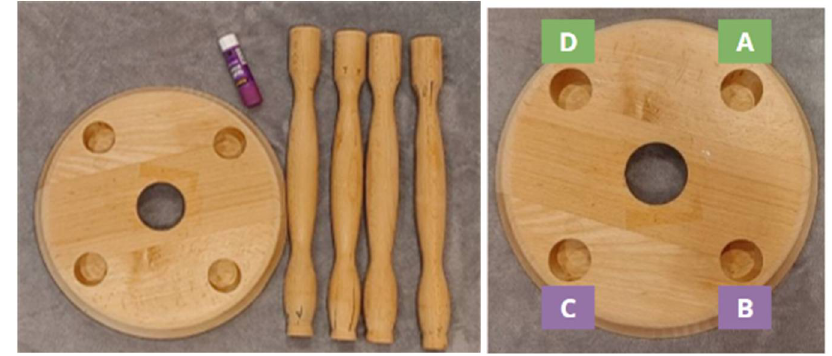
Figure 6. Experiment Workpieces.